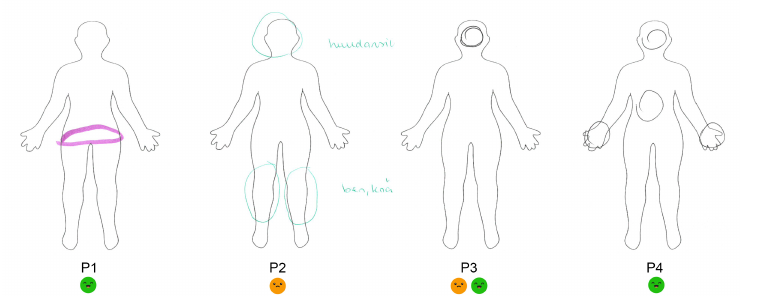
Figure 11. Body maps displaying where the students described that they could perceive vibrations when they were sitting or lying on the floor (FH). Green versus orange emojis represent the replies to whether the student liked or disliked the vibrations. P3 has both colors since he described that he disliked the vibrations using PODD, but the teacher interpreted it as though he liked